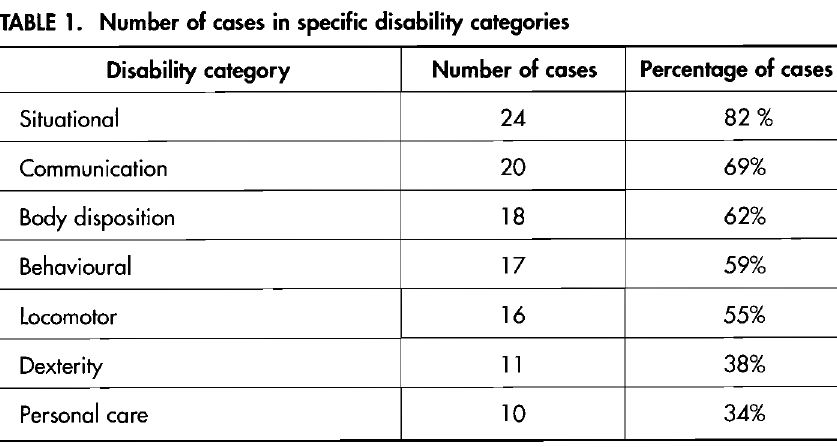
TABLE 1. Number of cases in specific disability